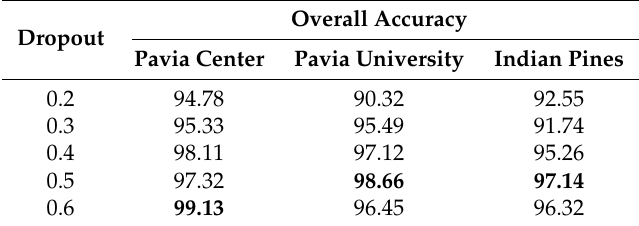
Table 6. OA of proposed method with different spatial